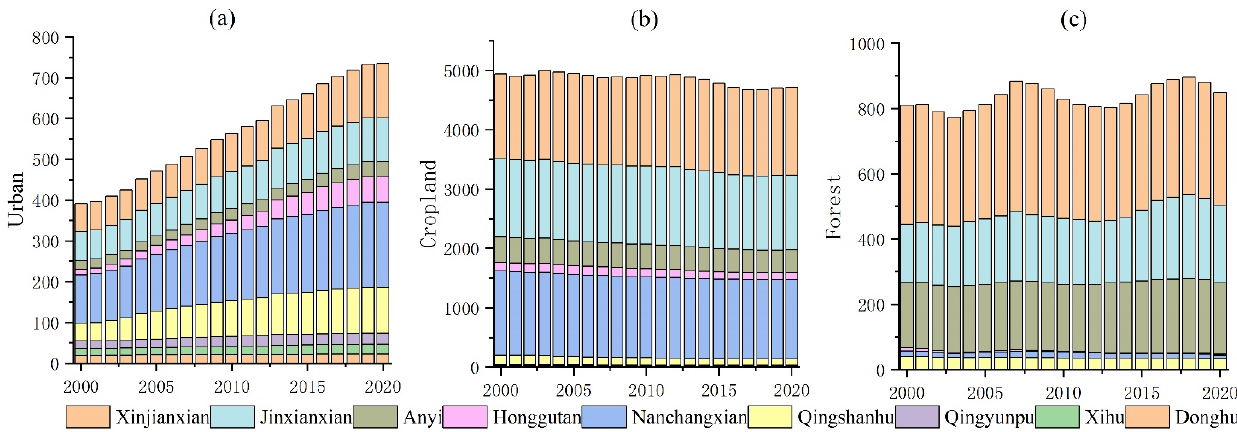
Figure 5. Area of urban, cropland, forest changing patterns (unit: km 2 ). ( a ) changing patterns of urban area from nine counties; ( b ) changing patterns of cropland area from nine counties; ( c ) changing patterns of forest area from nine counties.